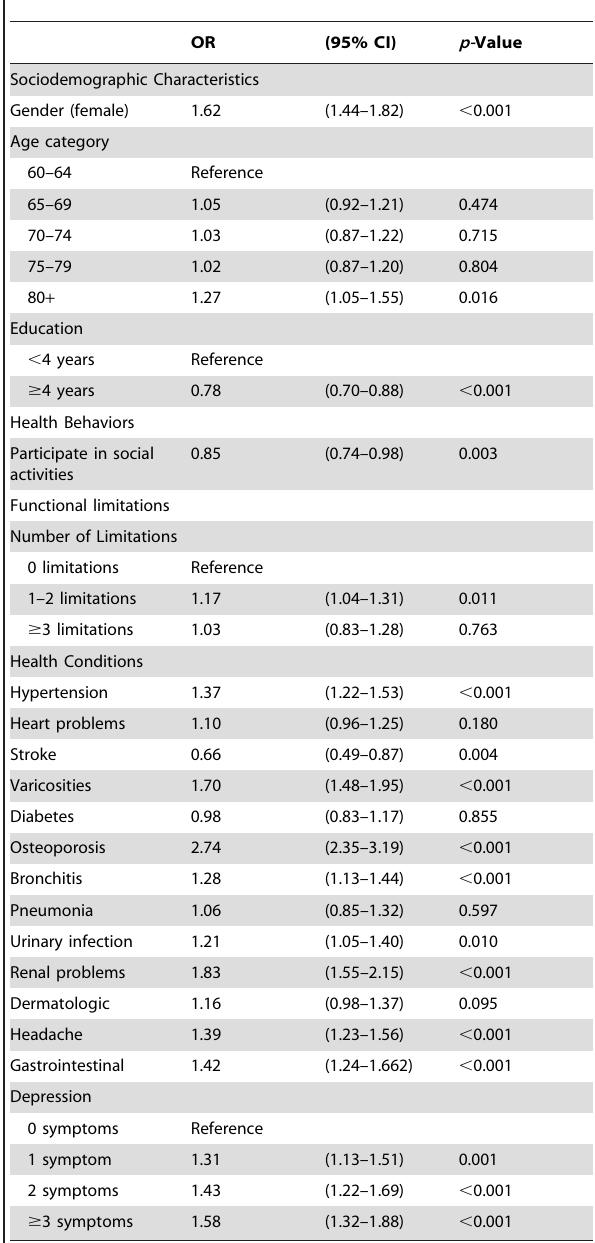
Table 2. Concomitants of arthritis. Multivariable logistic regression for total